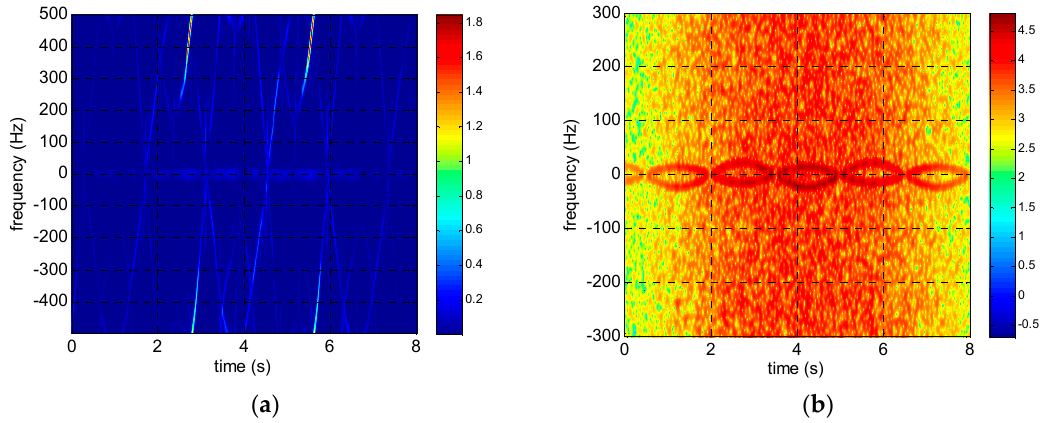
Figure 6. Time–frequency distributions of corner reflectors rotating at 20 r/min ( a ) before and ( b ) after intra ‐ pulse interference processing.